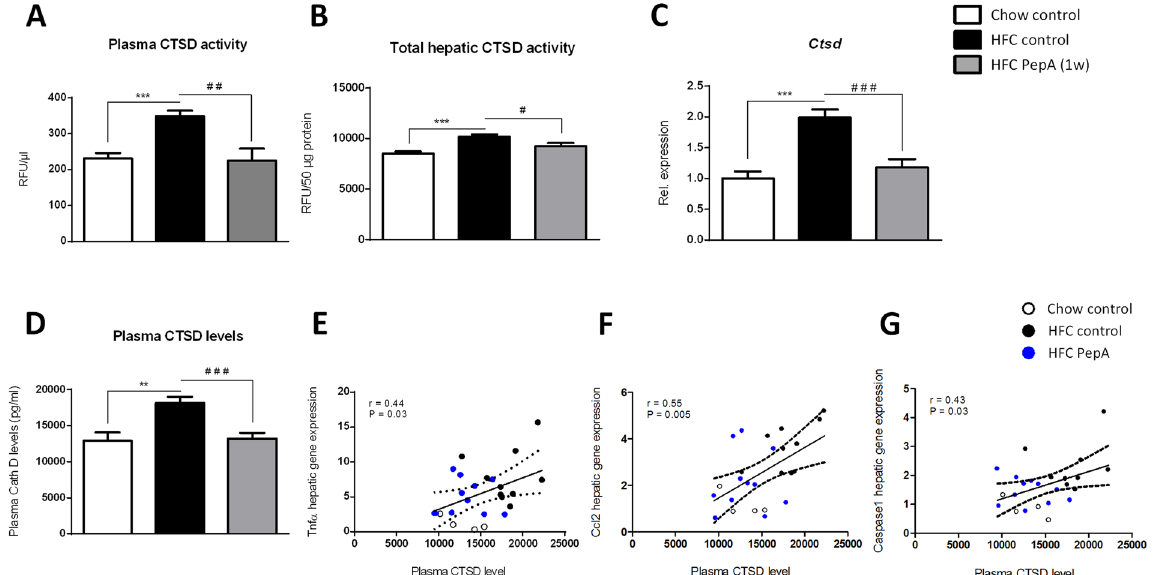
Figure 2. Parameters of lysosomal function in control- and PepA-injected mice. ( A,B ) Plasma ( A ) and hepatic ( B ) activity of CTSD. ( C ) Hepatic gene expression analysis of Ctsd . Data are shown relative to control mice on chow diet by use of two-tailed unpaired t test. ( D ) Plasma levels of CTSD. ( E–G ) Correlation between plasma levels of CTSD and hepatic gene expression of Tnf α , Ccl2 and Caspase1 by Pearson correlation. Error bars represent ± SEM. ** Indicates p < 0.01 and *** p < 0.001 compared to mice on chow diet; # indicates p ≤ 0.05, ## p < 0.01 and ### p < 0.001 compared to control-injected mice on HFC diet by use of two-tailed unpaired t test. n = 9–11 animals in each group. For correlation analysis, n = 4 animals on chow diet and n = 10 for mice on HFC